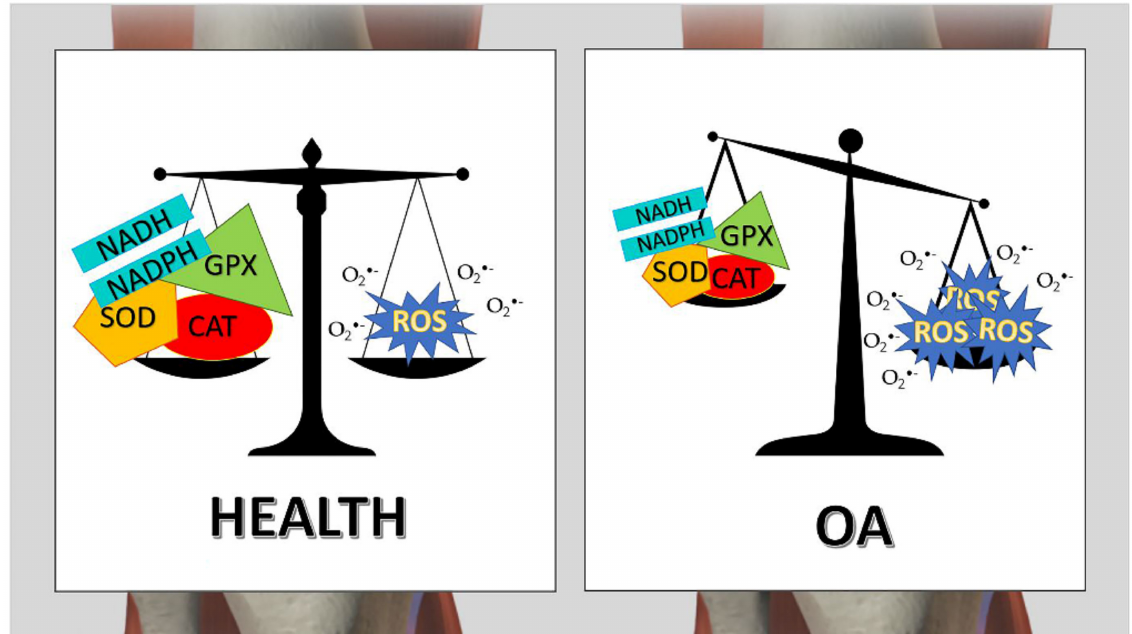
Figure 1. Oxidative stress in OA disease. The balance between anti -ROS molecules and ROS, production is reported both in healthy and OA